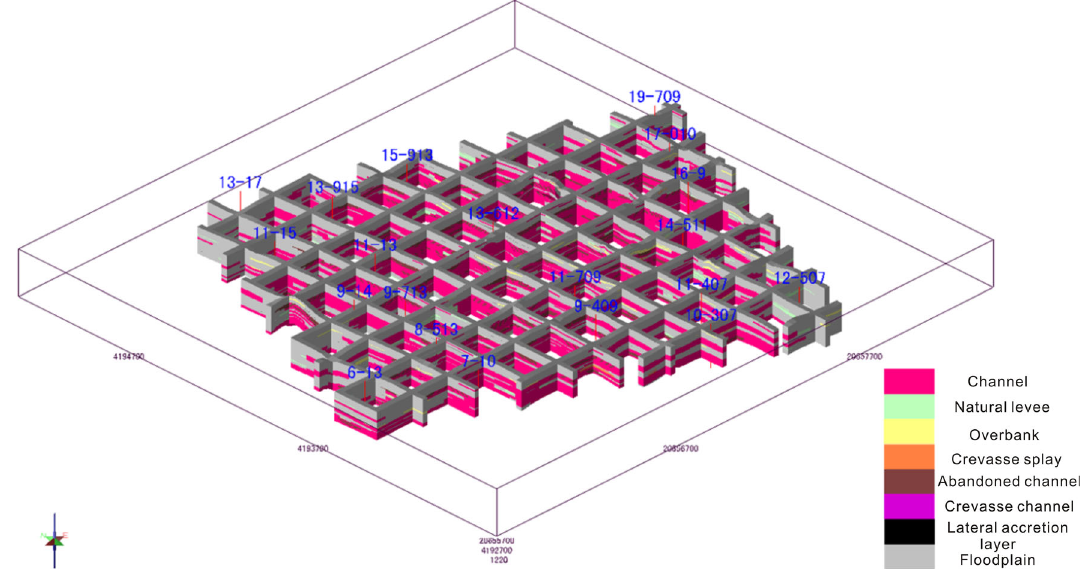
Fig. 10 Three-dimensional grid chart of architecture model in Ng33 thin